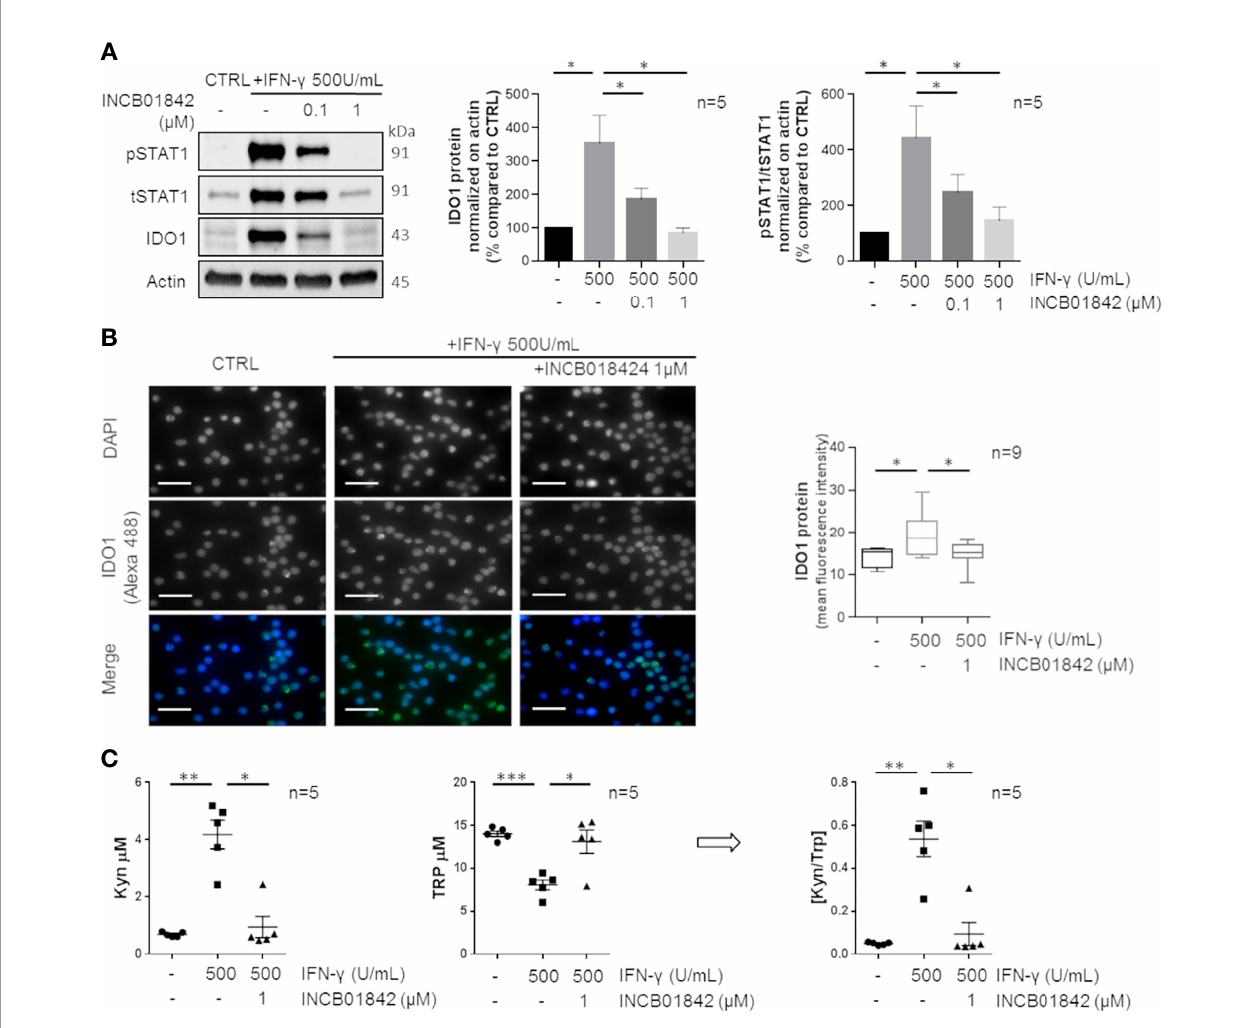
FIGURE 2 | IDO1 protein induction and activity can be regulated by IFN- g in CLL. (A) Puri fi ed CLL cells were pretreated with two doses (0.1 – 1 m M) of INCB018424 for 1 h prior to IFN- g stimulation for 24 h. Immunoblots depict IDO1, tSTAT1, and pSTAT1 protein levels in a representative case. Histograms on the right represent the densitometric quanti fi cations of IDO1 and pSTAT1/tSTAT1 in 5 CLL samples (Student paired t test, *p < 0.05; n = 5). (B) Immuno fl uorescence staining shows the ability of INCB018424 1 m M to reduce IDO1 expression induced by IFN- g . Scale bar is 20 µm. Box plots summarize the fl uorescent levels in DMSO, IFN- g , or IFN- g + INCB018424-treated CLL cells(Student paired t test, *p < 0.05; n = 9). (C) Conditioned media were collected after INCB018424 pretreatment (or not) and IFN- g incubation for 24 h. Dot plots on the left represent the mean of the Kyn concentration measured by LC-MS/MS analytical technique in 5 separated experiments (Student paired t test, *p < 0.05, **p < 0.01; n = 5). The central dot plots represent the mean of the Trp concentration (Student paired t test, *p < 0.05, ***p < 0.001; n = 5). The resultant [Kyn]/[Trp] ratio calculated is depicted in the right dot plot (Student paired t test, *p < 0.05, **p < 0.01; n =